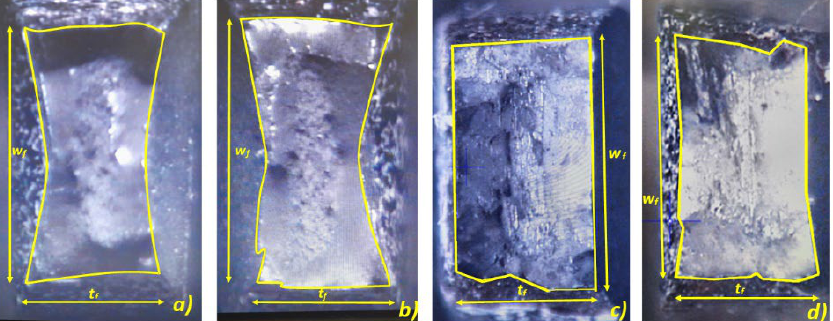
Figure 6. Failed neck sections of DP 1000 ( a , b ) and MS 1700 steels ( c , d ) from static tests ( a , c ) and dynamic tests at 500 s − 1 ( b , d ).